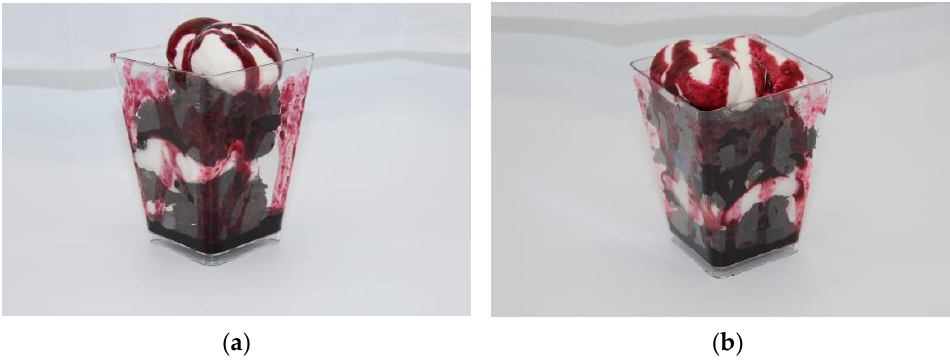
Figure A3. Brownie dessert that was presented to participants for product evaluation. ( a ) Brownie dessert contained the Control brownie used in the study and ( b ) the brownie dessert contained the CP pasta. Table A3. Ingredients used and their sources for the brownie dessert. The pasta component shows the formulations for both the Control and CP versions. Usage levels (%) shown are the percentages used for each dish component. Percentages were rounded to the nearest hundredths.